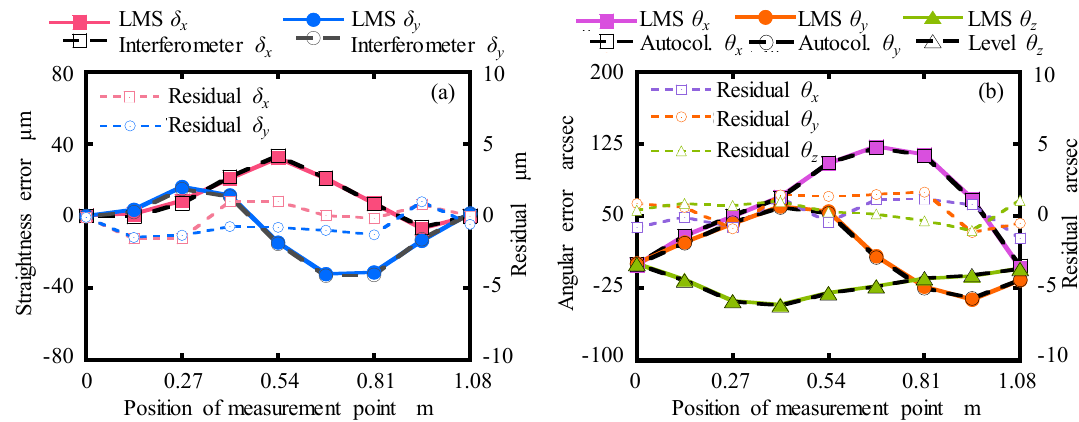
Figure 12. Error motions of the linear stage: ( a ) δ x and δ y , ( b ) θ x , θ y , and θ z .